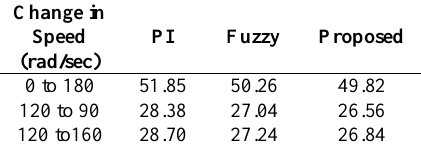
Table II. The RMSE results